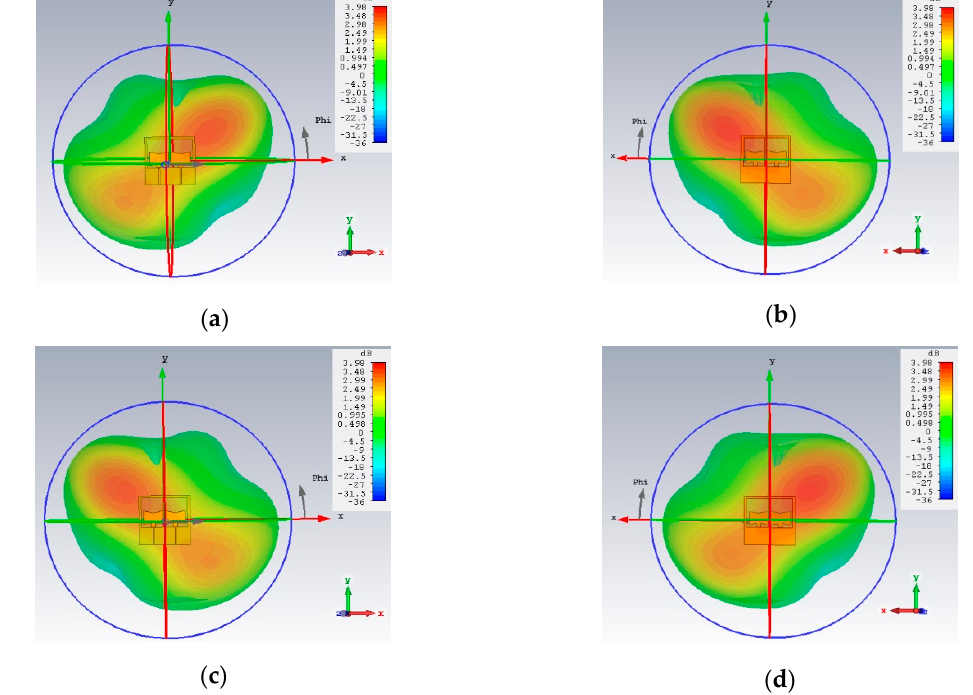
Figure 14. 3D Realized Gain patterns in the high frequency band (1.78 GHz): ( a ) and ( b ) in front of and back of the antenna plane (port p1 is fed), ( c ) and ( d ) respective results feeding port p2. Figure 15a,b depict the box charts for V DC and P in_rec received for waves incoming from seven different DoAs within a region ±45° around -z- axis form the front side of the antenna and